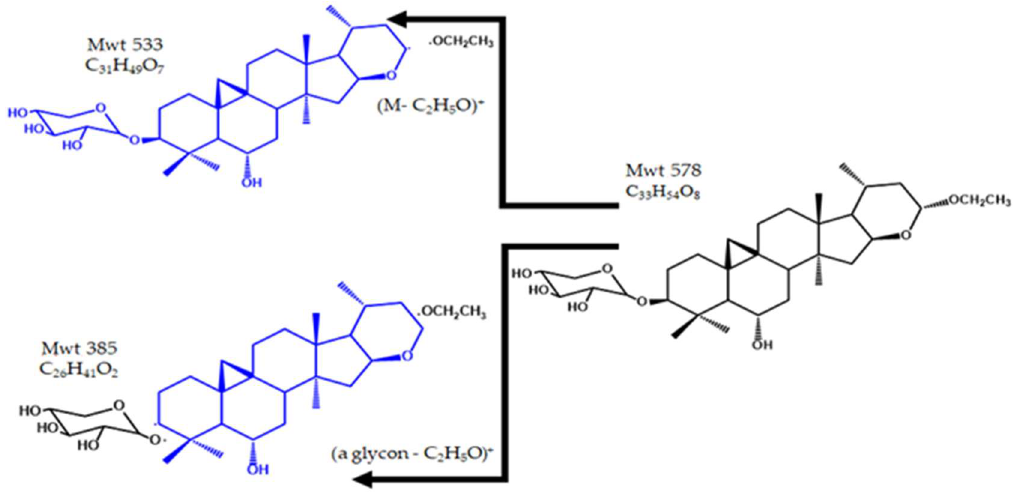
Figure 10. The structure and fragmentation of deacetyl tomentoside I.